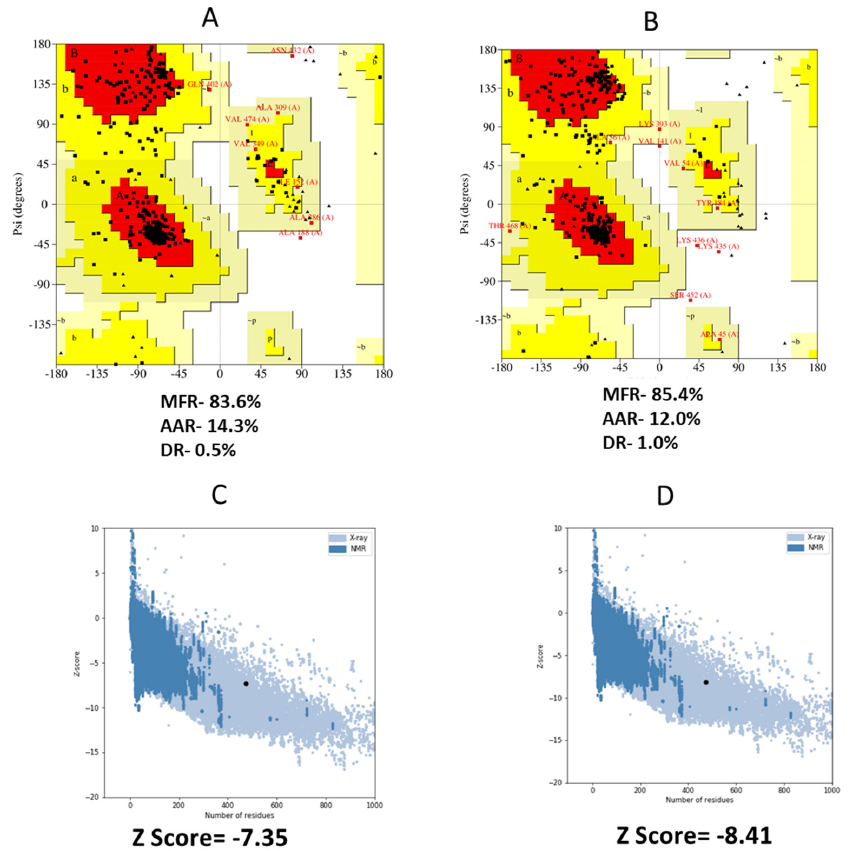
Figure 6. ( A , B ) PROCHECK server analysis of Ramachandran plot. The most preferred, additionally